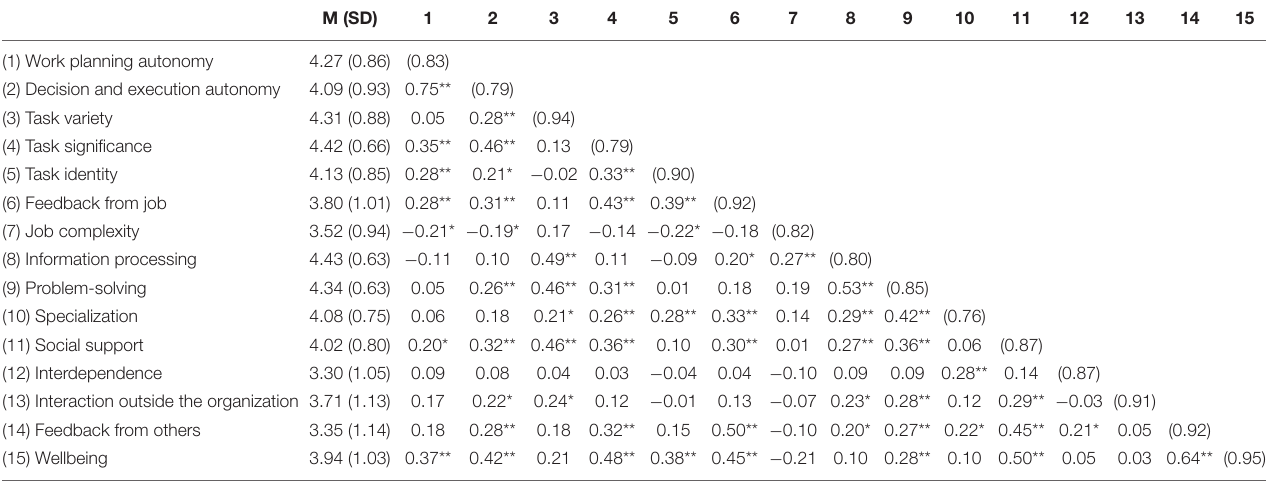
TABLE 1 | Descriptive, correlations and Cronbach’s alpha on the diagonal.